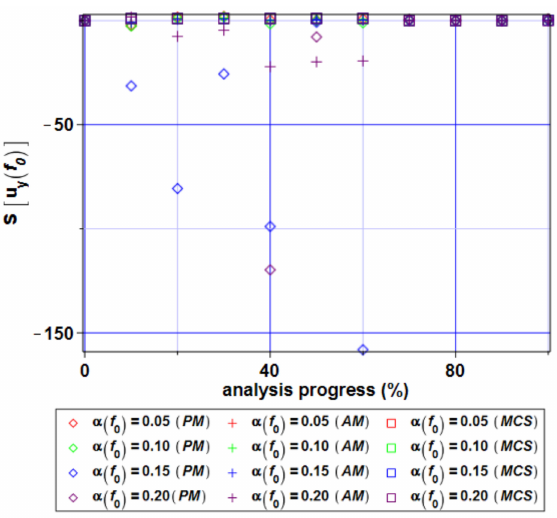
Figure 21. Skewness of the extreme vertical displacements S[u y (f 0 )] for the